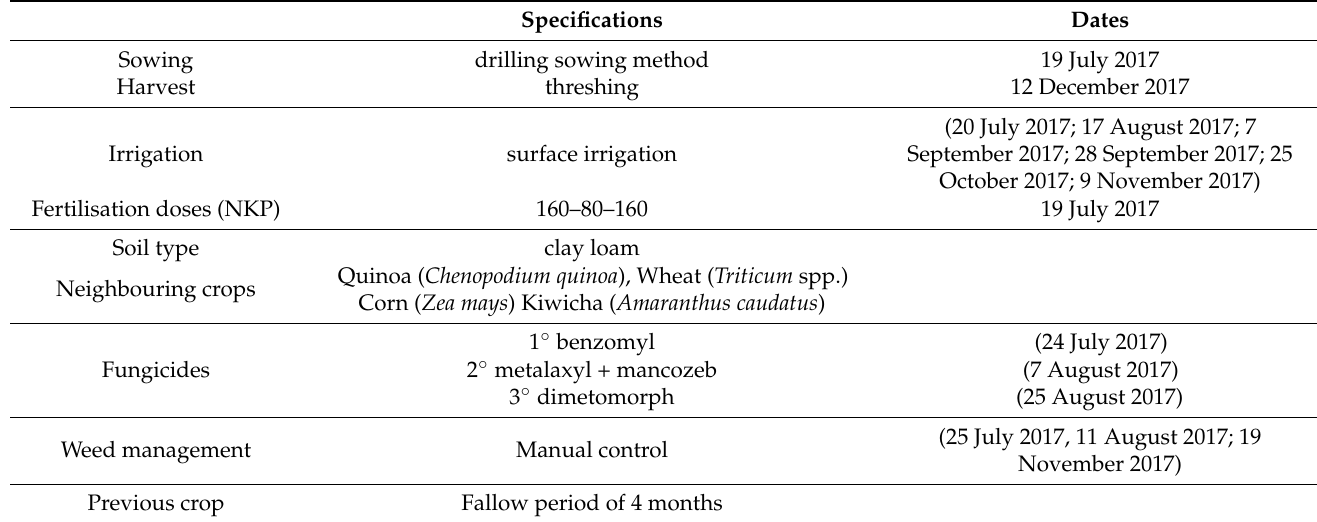
Table 5. Growing specifications of the experimental field.